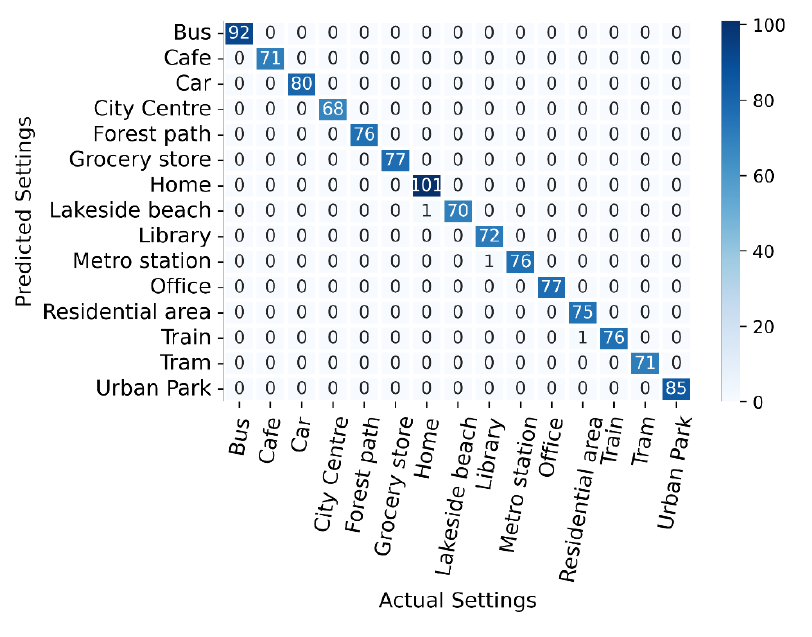
Figure 9. Confusion matrix of scene classification with 12 MFCC features.